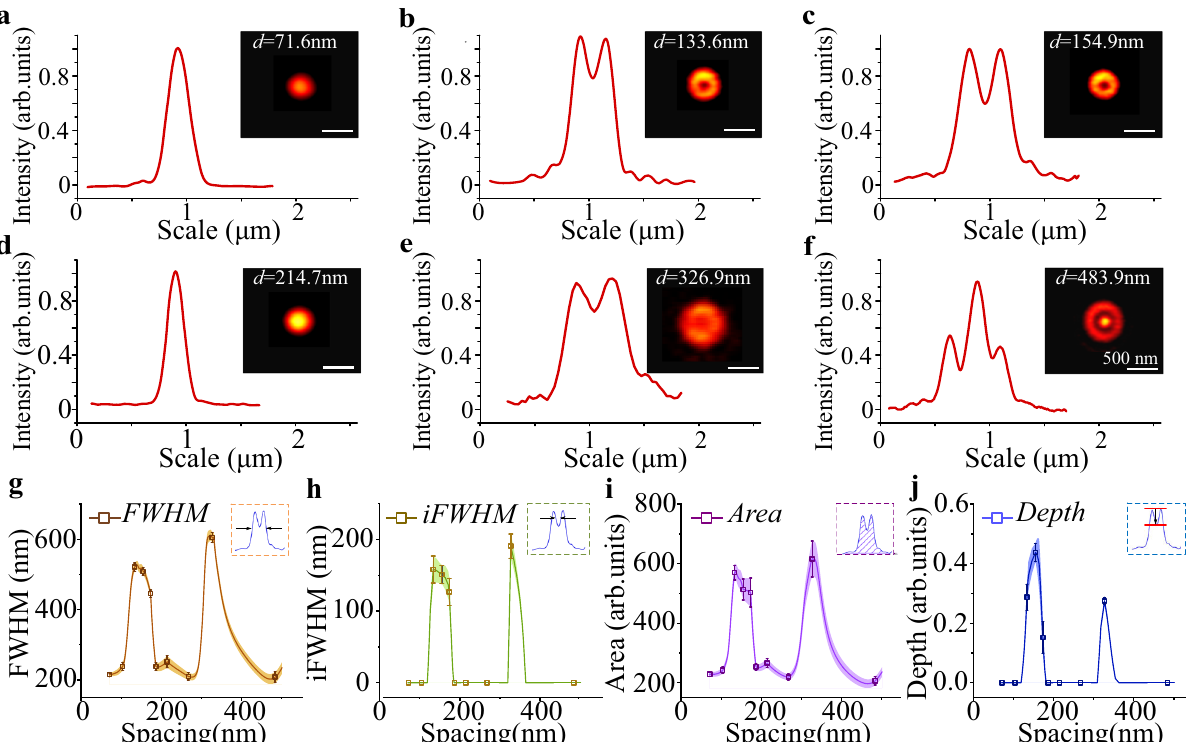
Fig. 3 Features and quantitative analysis of the series of observed lateral PSFs used for determining the distance between UCNP and mirror. a – f Cross-section line pro fi les of the lateral PSF of UCNPs (shown as insets) for six different spacings. g – j The four characteristic parameters, including FWHM , iFWHM , area , and depth , respectively, were measured as a function of the distance between UCNP and mirror. Additional PSF analysis results for 455 and 800 nm emission are provided in the Supplementary Figs. 16 and 17, respectively. Further details for resolution analysis are explained in Supplementary Information Note 5. Error bars are based on the standard deviation. All scale bars in this fi gure are 500